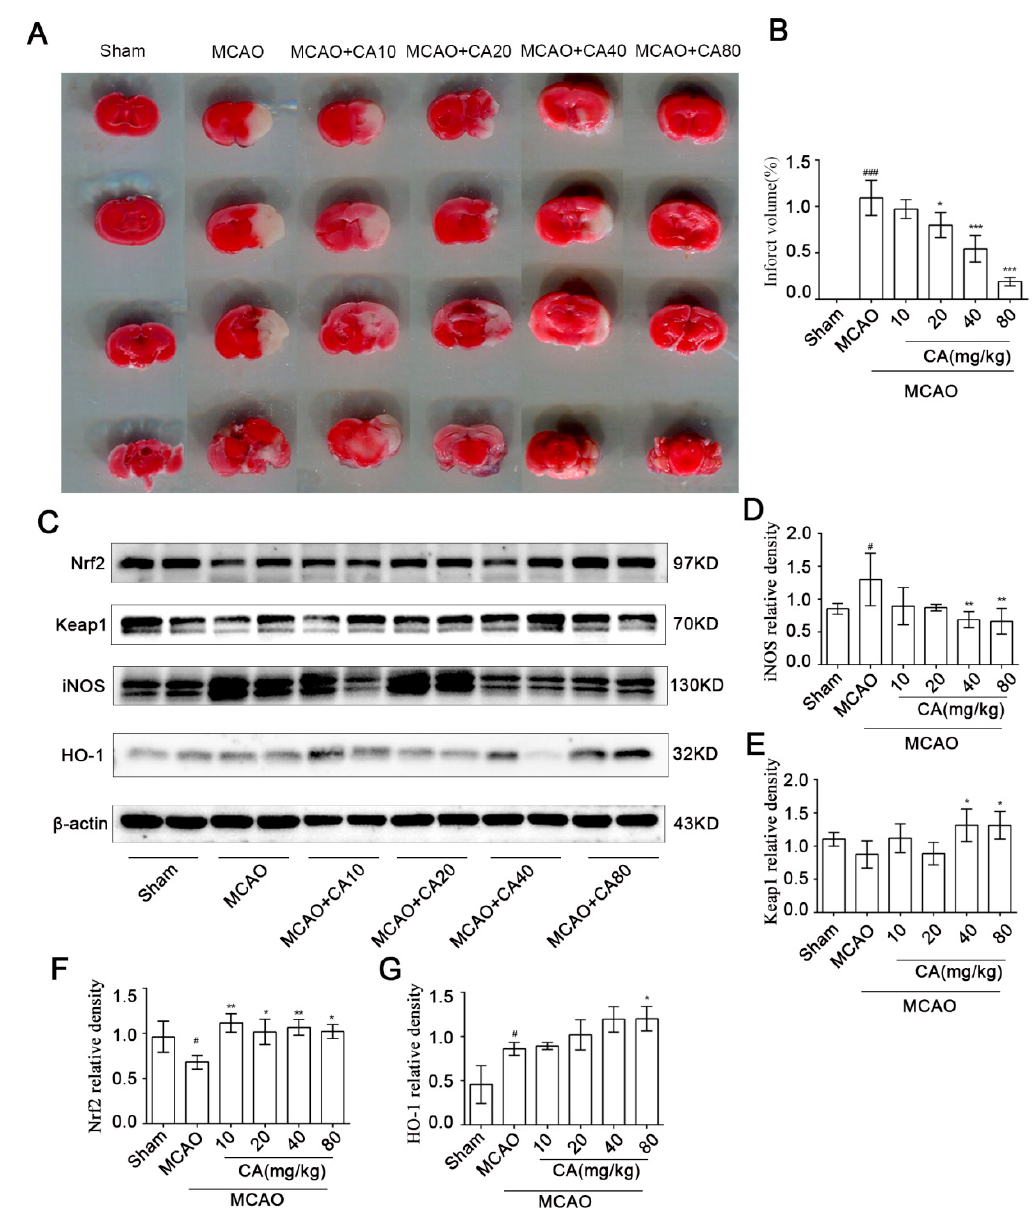
Figure 5. CA reduced infarct volume after ischemia-reperfusion in vivo. ( A , B ) Cerebral infarct volumes of rats in different treatment groups. Red staining represents normal tissues, and white staining represents the infarct region. ( C – G ) Chebulic acid increases activation of the Nrf2-ARE pathway in vivo. Western blot analysis was performed with specific antibodies to detect the activation of Nrf2, Keap1, iNOS, and HO − 1 in the ischemic hemisphere (representative images from three independent experiments are shown). The results are expressed as mean ± SD. # p < 0.05 and ### p < 0.001 compared with the sham group. * p < 0.05, ** p < 0.01, and *** p < 0.001